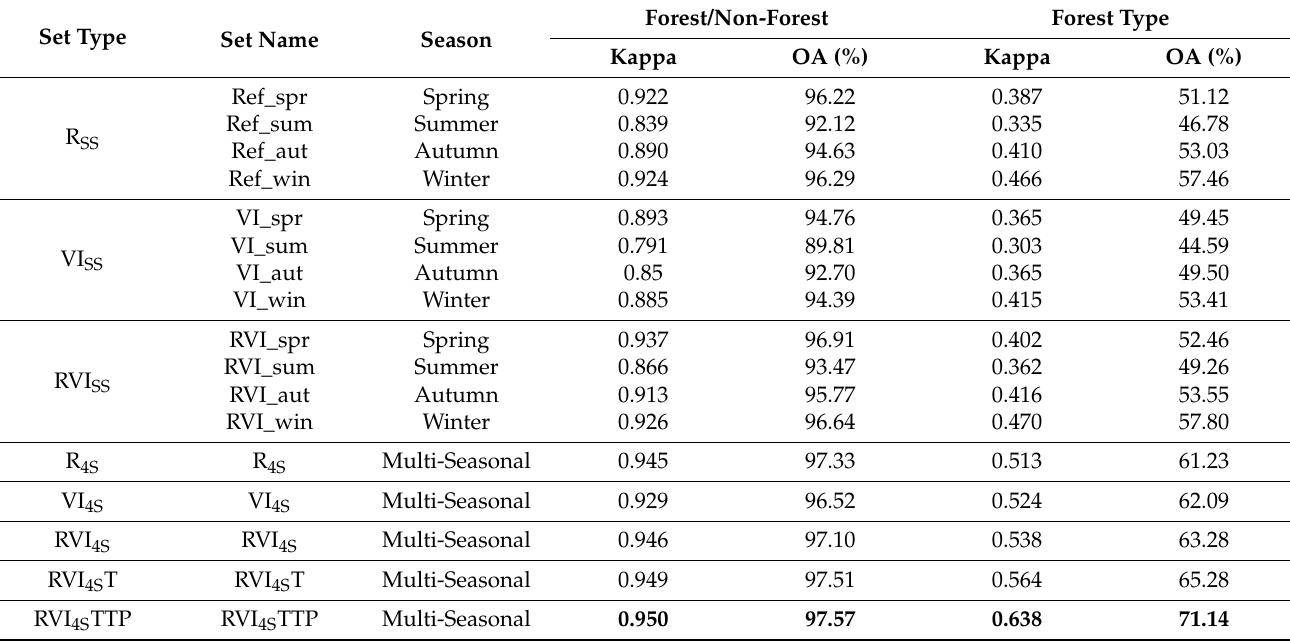
Table 9. The OA and Kappa obtained with different feature